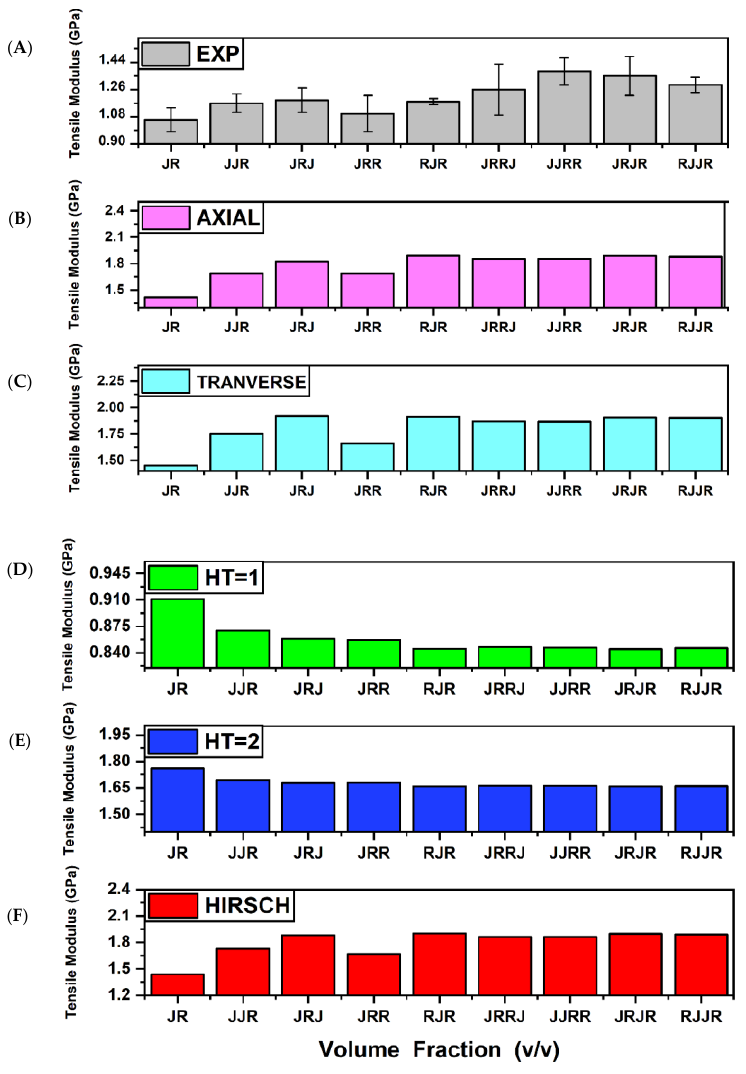
Figure 2. Modulus of composite hybrid: ( A ) Experiment ( B ) ROM ( C ) IROM, ( D ) HT = 1 ( E ) HT = 2. ( F ) HI.